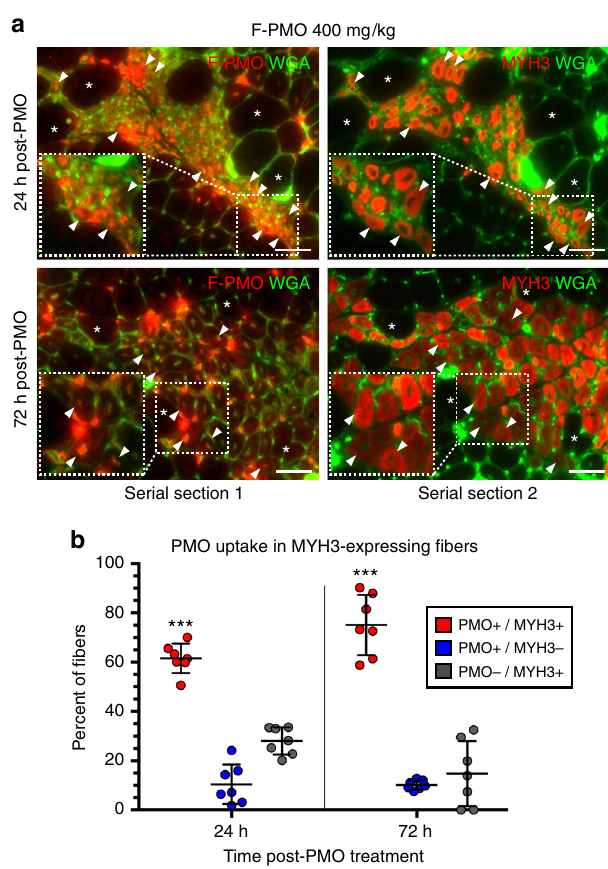
Fig. 5 PMO uptake prevalent among actively regenerating myo fi bers expressing embryonic myosin heavy chain. a PMO localization and uptake speci fi c to regenerating myo fi ber clusters expressing MYH3, after systemic F-PMO delivery in 4 week mdx mice (400 mg/kg, n = 3). Co-localization of PMO and MYH3 +ve myo fi bers examined in gastrocnemius, quadriceps, and triceps at 24 and 72 h post-PMO delivery. Asterisks denote fi ber identity between serial cross-sections; arrowheads denote examples of MYH3 +ve myo fi bers with nuclear PMO. Dashed boxes show magni fi ed inlay; scale bars represent 50 μ m. b Quanti fi cation of PMO localization in MYH3 +ve myo fi bers shown as percent of labeled fi bers. Statistical analysis performed by Mann – Whitney nonparametric test; *** p < 0.001. Data represented